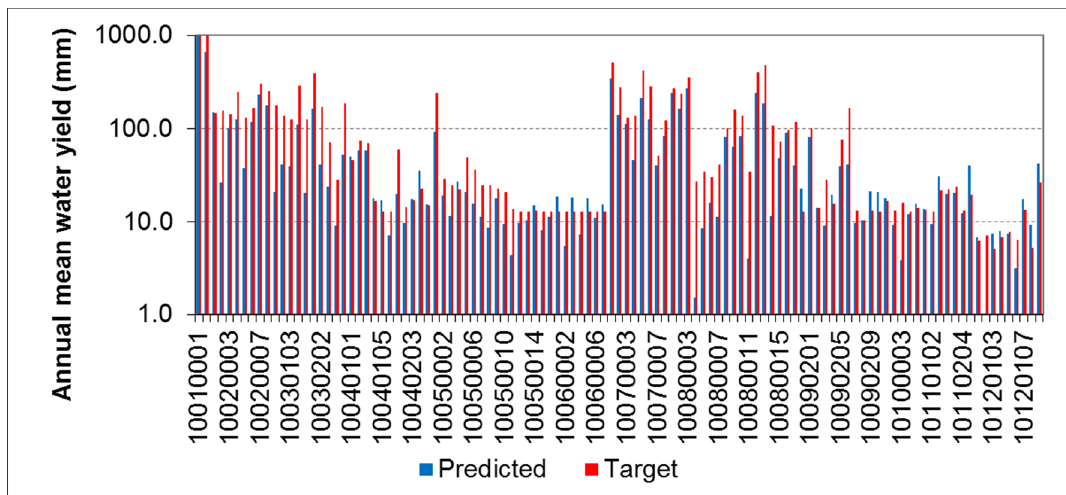
Figure 6. Annual water yield for Missouri river basin. Table 3. Major mismatches between the Soil and Water Assessment Tool (SWAT) predictions and calibration targets.